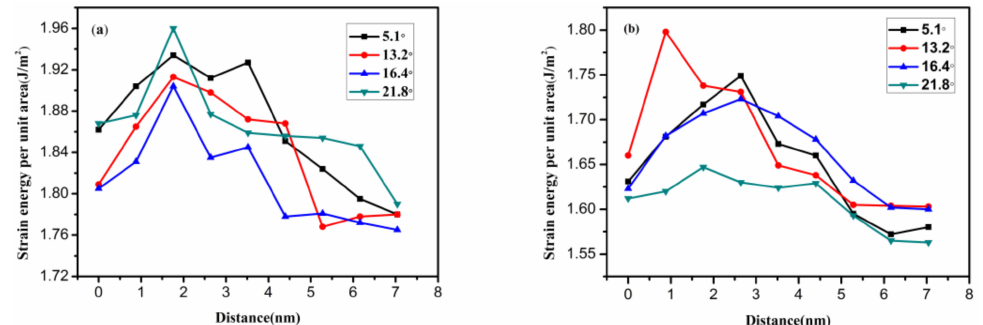
Figure 6. The variation in strain energy per unit area with increasing distance from the GB: ( a ) when the load is perpendicular to the GB; ( b ) when the load is parallel to the